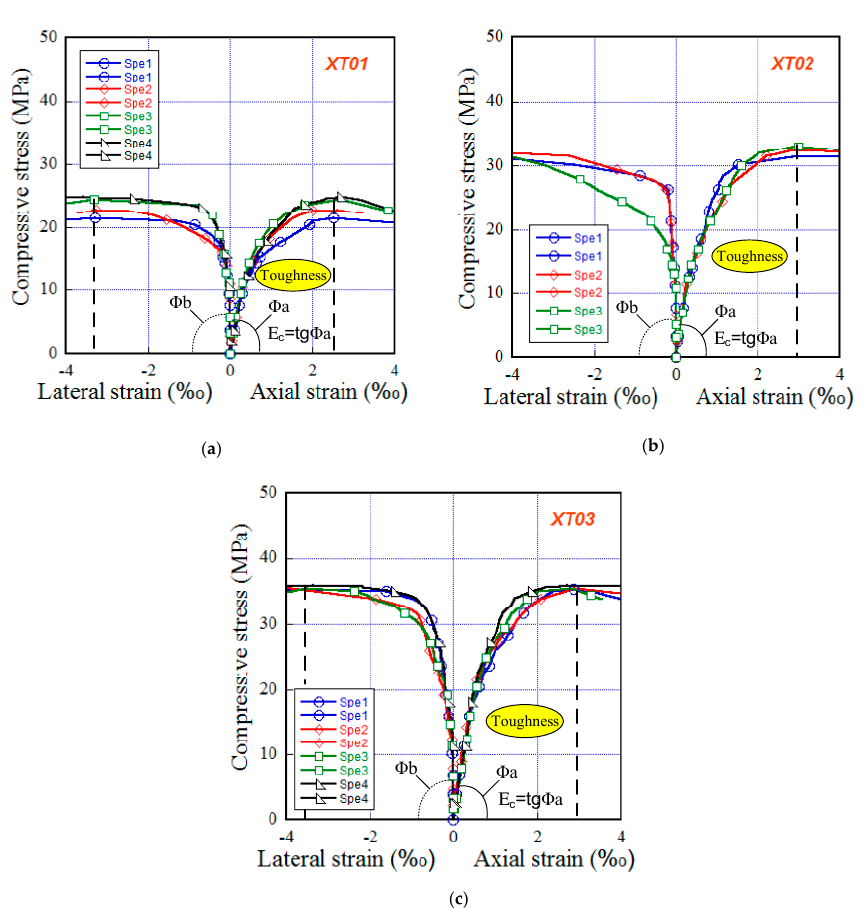
Figure 7. Compressive responses of the investigated steel-slag concretes at the 28-day age using cylinder specimens of 150 × 300 mm. ( a ) XT01. ( b ) XT02. ( c ) XT03.